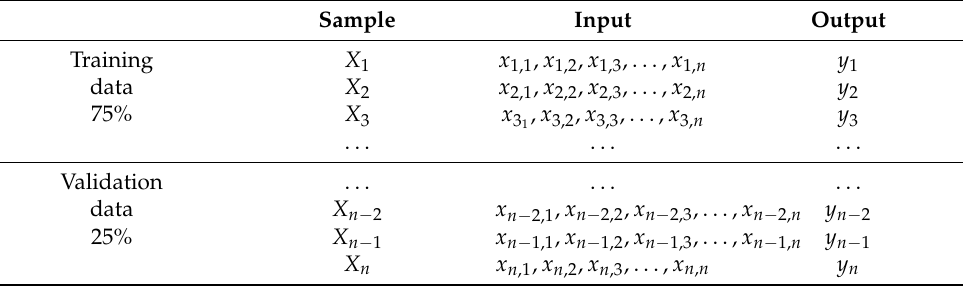
Table 4. Database split into 75% of samples for training and 25% of samples for